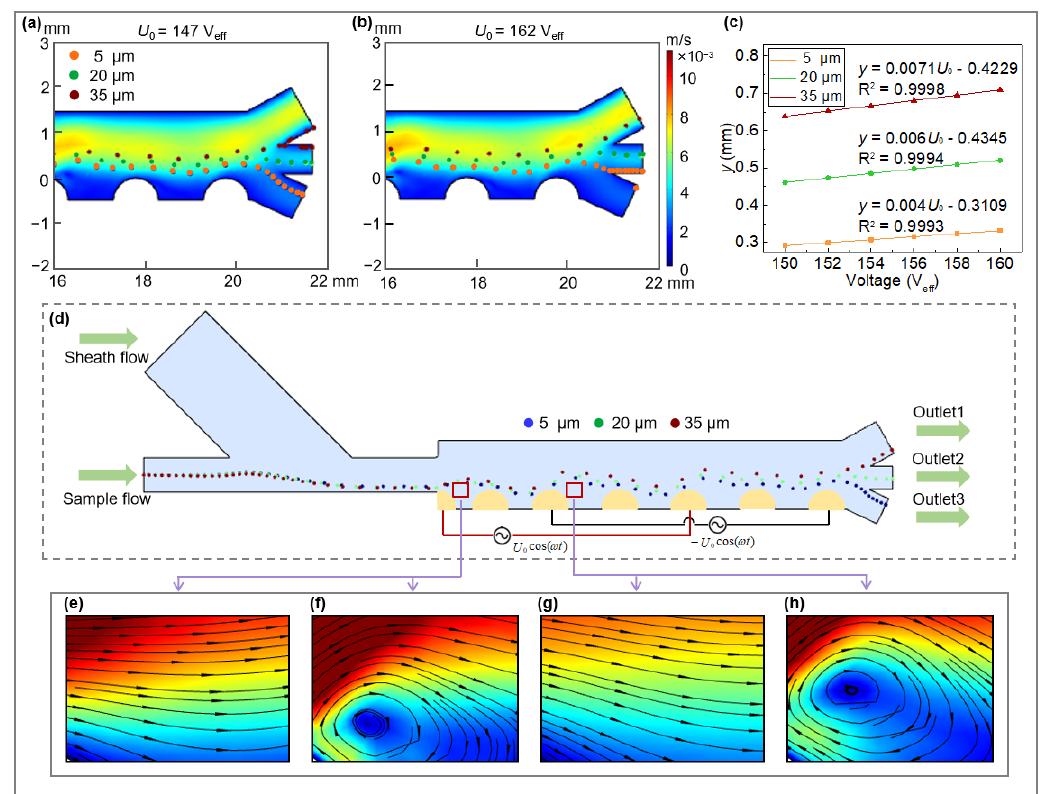
Figure 3. Effect of voltage on PS particle fractionation at u 1 = 2.5 mm/s, u 2 = 1.5 mm/s: ( a , b ) Fractionation of 5, 20 and 35- µ m PS particles under the input voltage of ( a ) U 0 = 147 V eff and ( b ) U 0 = 162 V eff with velocity distribution as the background; ( c ) the dependence of applied voltage on levitation height of three different PS particles at x = 20.3 mm; ( d ) motion trajectories of three PS particles within the separator at U 0 = 152 V eff ; ( e – h ) fluid flow profile in the absence of the thermal field ( e , g ) and in the presence of the thermal field ( f , h